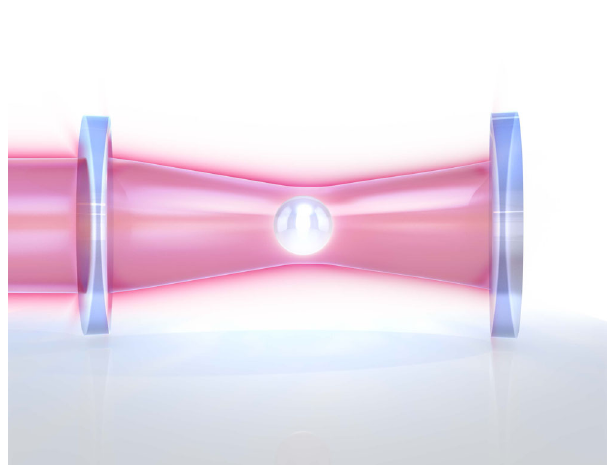
Fig. 1 An example of an optomechanical system. A nanodiamond is trapped and laser-cooled to milliKelvin temperatures in an optical